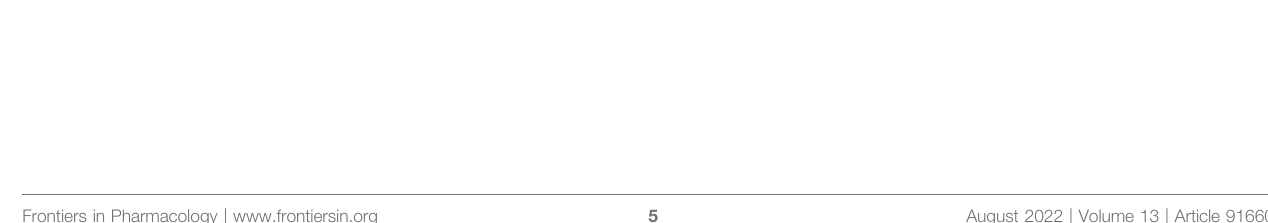
Frontiers in Pharmacology |